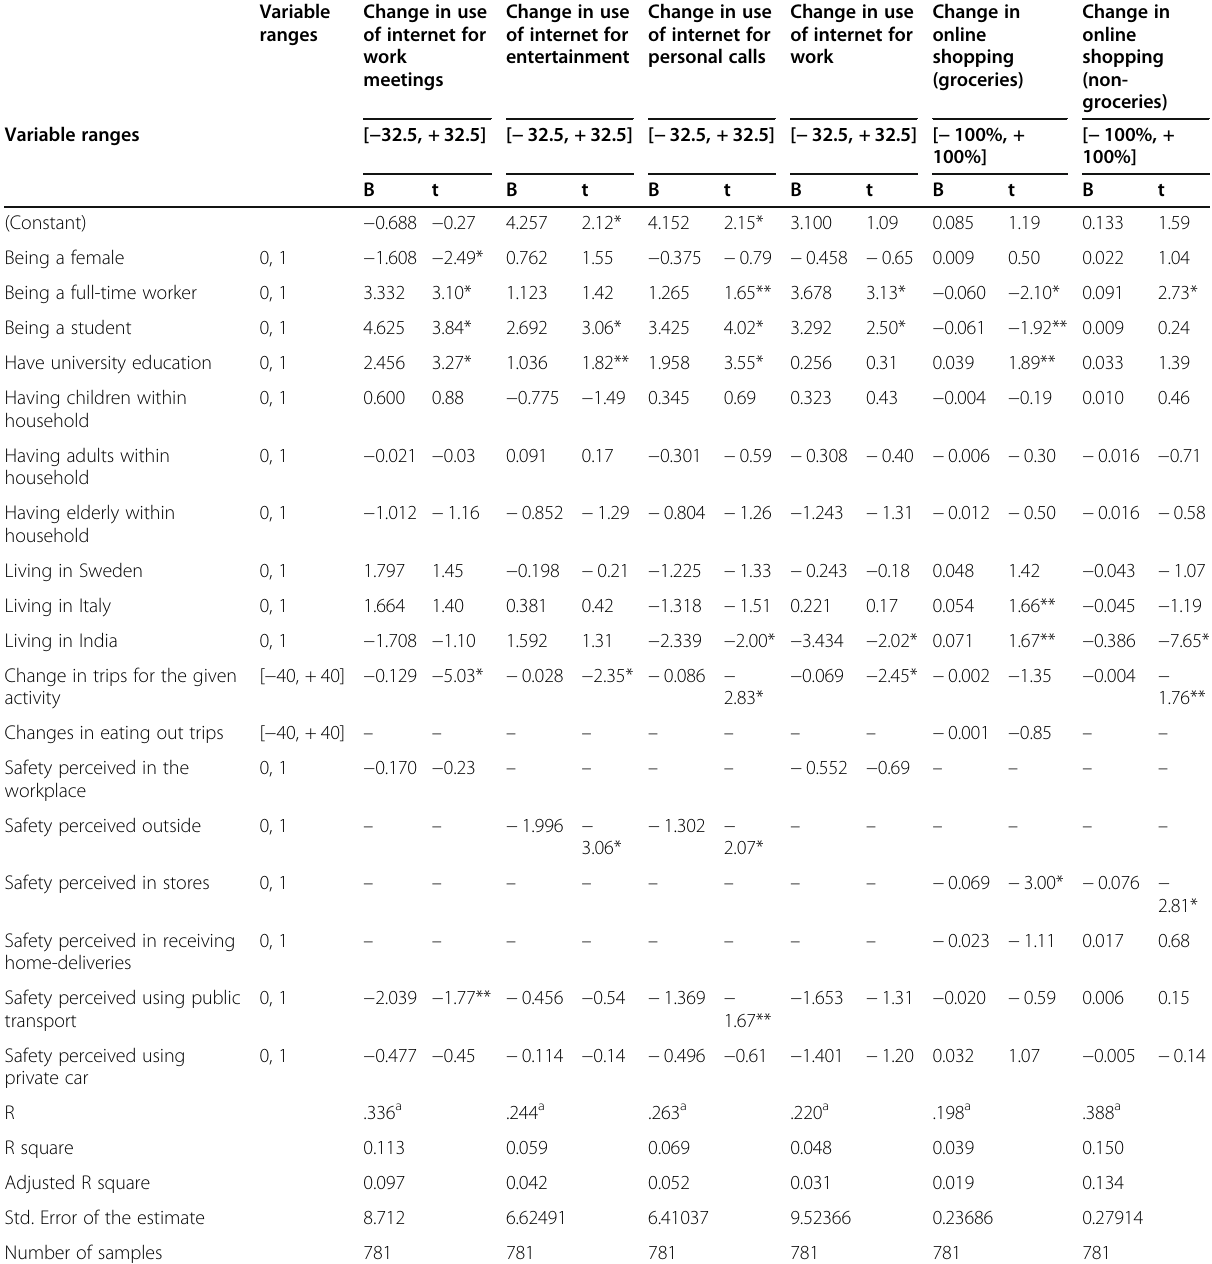
Table 3 Regression models for the increased amount in daily internet usages for different